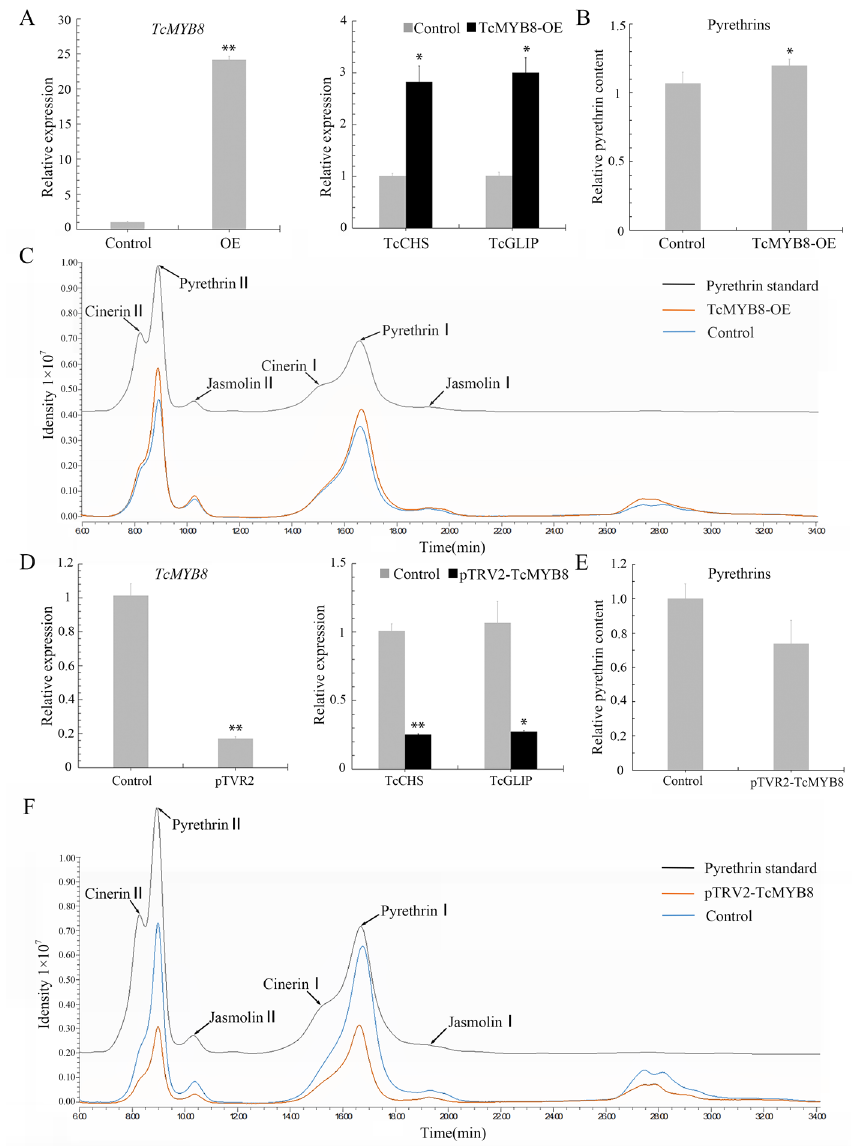
Figure 3. Functional characterization of TcMYB8 in T. cinerariifolium leaves. ( A ) Expression levels of pyrethrin biosynthetic genes in T. cinerariifolium leaves transiently expressing TcMYB8. Gene expression was detected by qRT-PCR at 4 days post-infiltration (dpi). ( B ) Relative pyrethrin content in T. cinerariifolium leaves after transient TcMYB8 overexpression at 4 days. ( C ) Contents of pyrethrin I and pyrethrin II in in T. cinerariifolium leaves transiently expressing TcMYB8. The ordinate represents the peak area detected by HPLC. The black arrows indicate the six major constituents of pyrethrins. Control: transient overexpression of the empty vector; TcMYB8-OE: transient overexpression of pGreen-62-SK-TcMYB8. ( D ) Expression levels of pyrethrin biosynthetic genes in T. cinerariifolium leaves expressing the Tobacco rattle virus (TRV) vector for silencing the TcMYB8 gene by virus- induced gene silencing (VIGS). Gene expression was detected by qRT-PCR at 14 dpi. ( E ) Relative pyrethrin content in T. cinerariifolium leaves after being silenced for TcMYB8 by TRV VIGS. ( F ) Contents of pyrethrin I and pyrethrin II in leaves silenced for TcMYB8 by TRV VIGS. The ordinate represents the peak area detected by HPLC. The black arrows indicate the six major constituents of pyrethrins. Control: transient expression of the pTRV2 empty vector and pTRV1; pTRV2-TcMYB8: transient expression of pTRV2-TcMYB8 and pTRV1. Values shown are the mean ± SE, for which asterisks indicate significance differences (two-tailed t-test, *: p < 0.05; **: p <